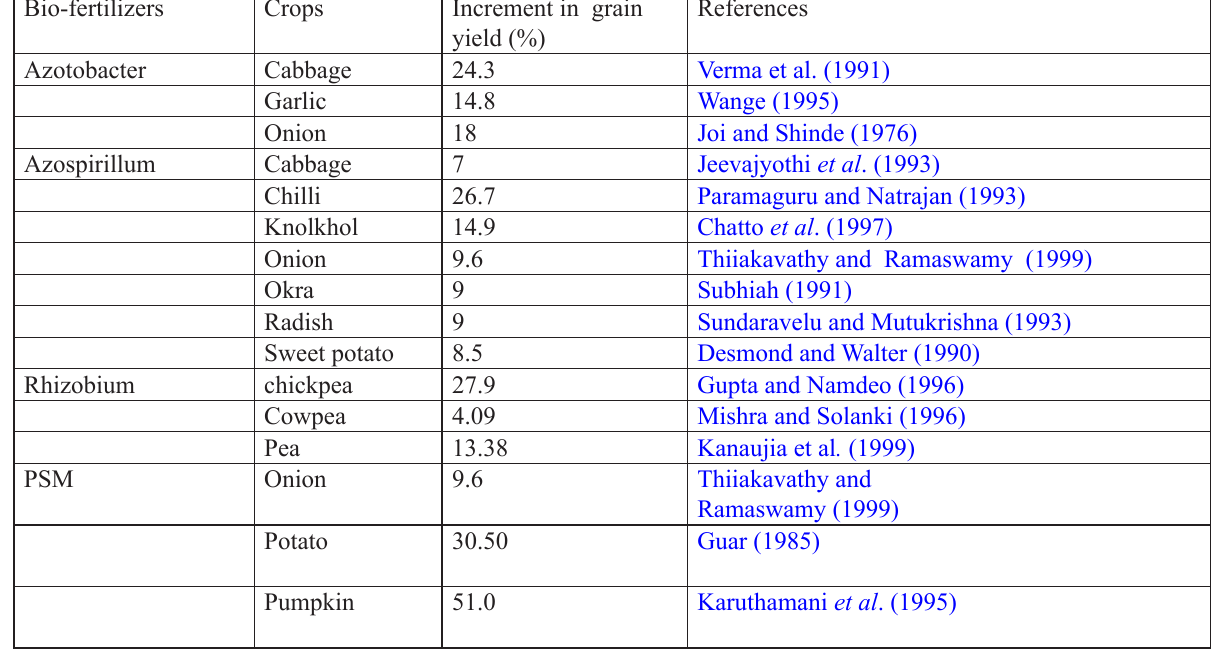
Table 3: Increments in grain yields of crops by biofertilizers